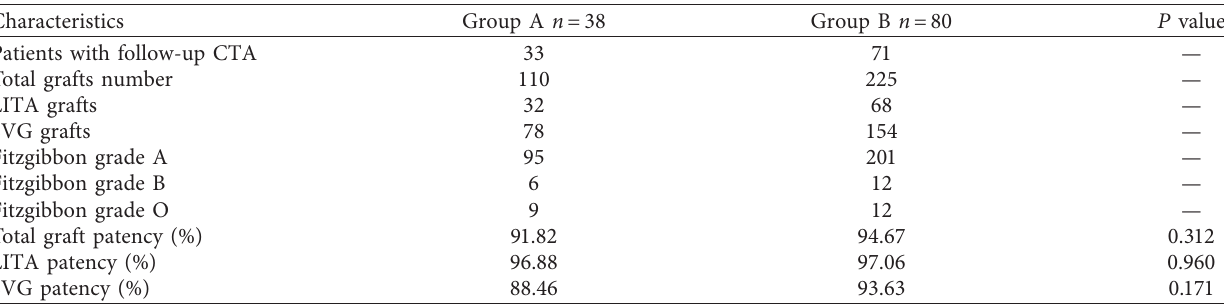
Table 5: One-year follow-up of CTA.